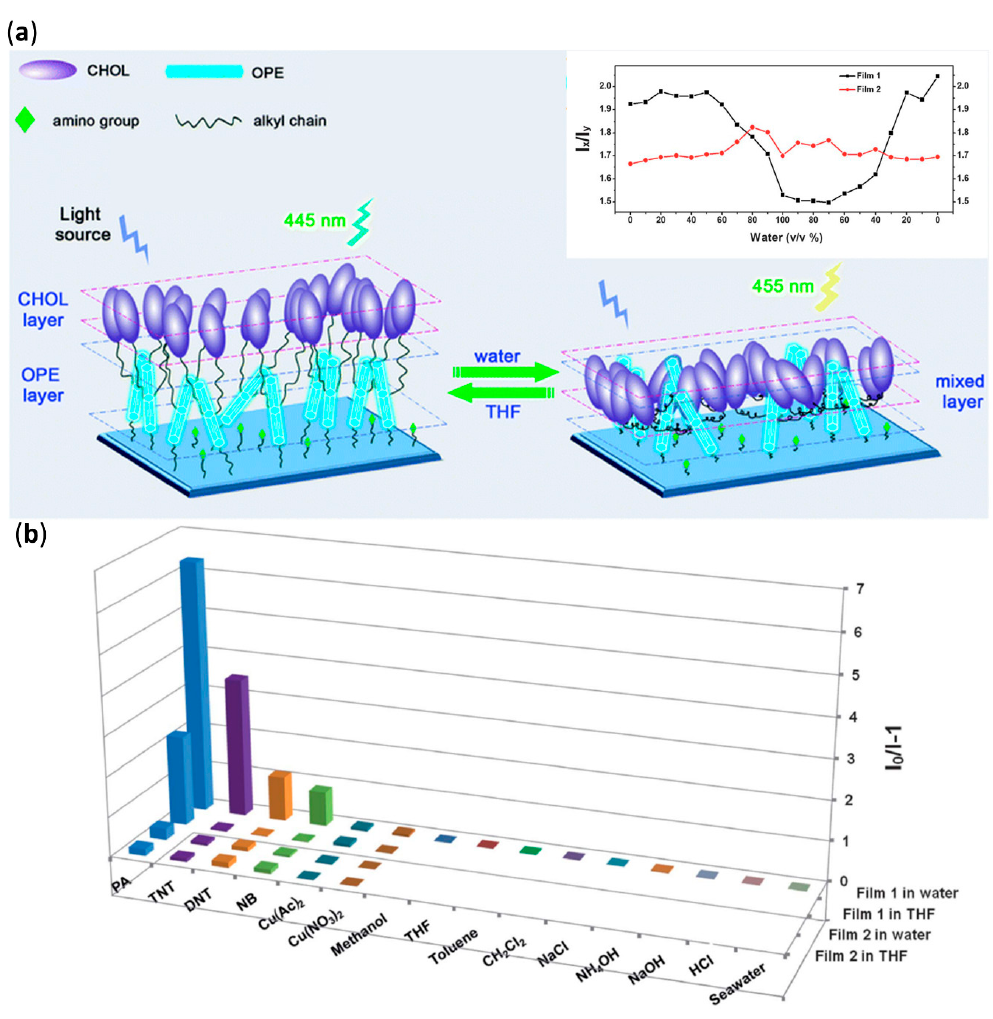
Figure 8. ( a ) The two states adopted by the oligomers containing cholesterol side chains (Table 1, no. 45) in water and tetrahydrofuran (THF), respectively. THF is a good solvent for oligomer and its cholesterol side chains and macromolecules in the film attain extended conformation. In contrast, water is a poor solvent for both the oligomer backbone and the side chains, thus the oligomer film is collapsed. Plots of the ratios of Ix/Iy of a given fluorescent film (Film 1-oligo(p-phenyleneethynylene) with cholesterol moieties and Film 2-pristin oligo(p-phenyleneethynylene)) against the compositions of the mixture solvents in which the fluorescence measurements were conducted (for Film 1 (Table 1, no. 45), ʎ em = 445 nm, y ʎ ex 500 nm; for Film 2 (Table 1, no. 44), ʎ em 374 nm, ʎ ex 420 nm). ( b ) Quenching efficiencies of various common explosive nitroaromatic compounds (NACs) on the fluorescence emission of Film 1 and Film 2 in water and THF, respectively, and the interferences of commonly found interferents in the sensing of Film 1 (concentration of NACs and interferents are 50 mM). Adapted from [87] with permission from The Royal Society of Chemistry.